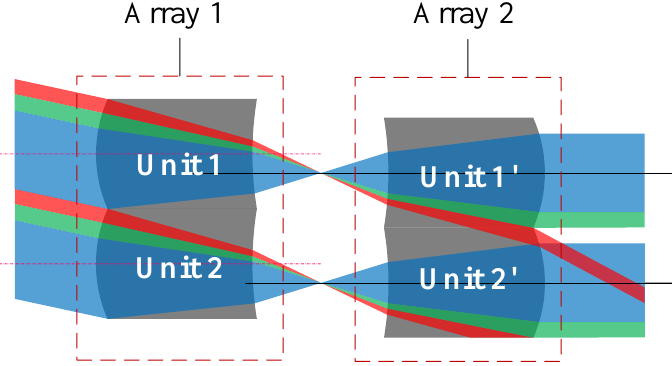
Figure 1. Schematic of the MLA system crosstalk stray light.